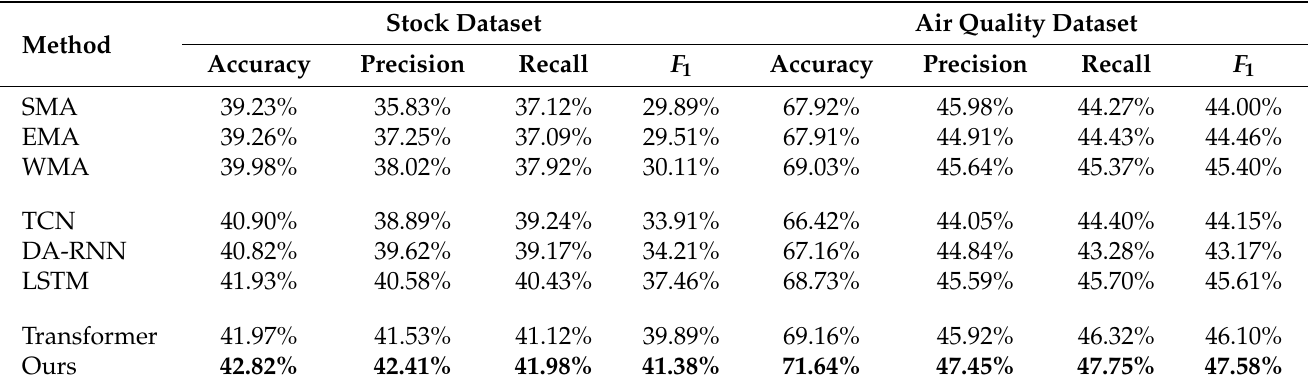
Table 4. Performance comparison between different